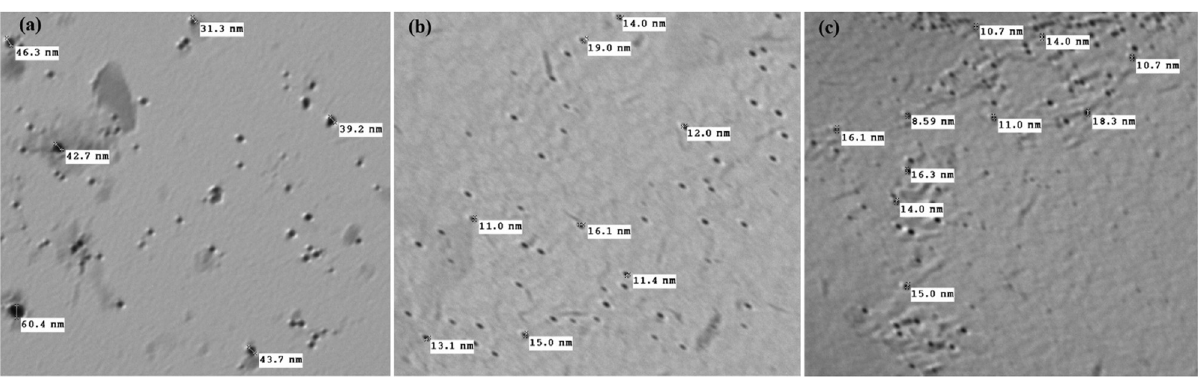
Figure 3: TEM images of TiO 2 nanoparticles at di ff erent irradiation doses: ( a ) 10 kGy, ( b ) 20 kGy, and ( c ) 30